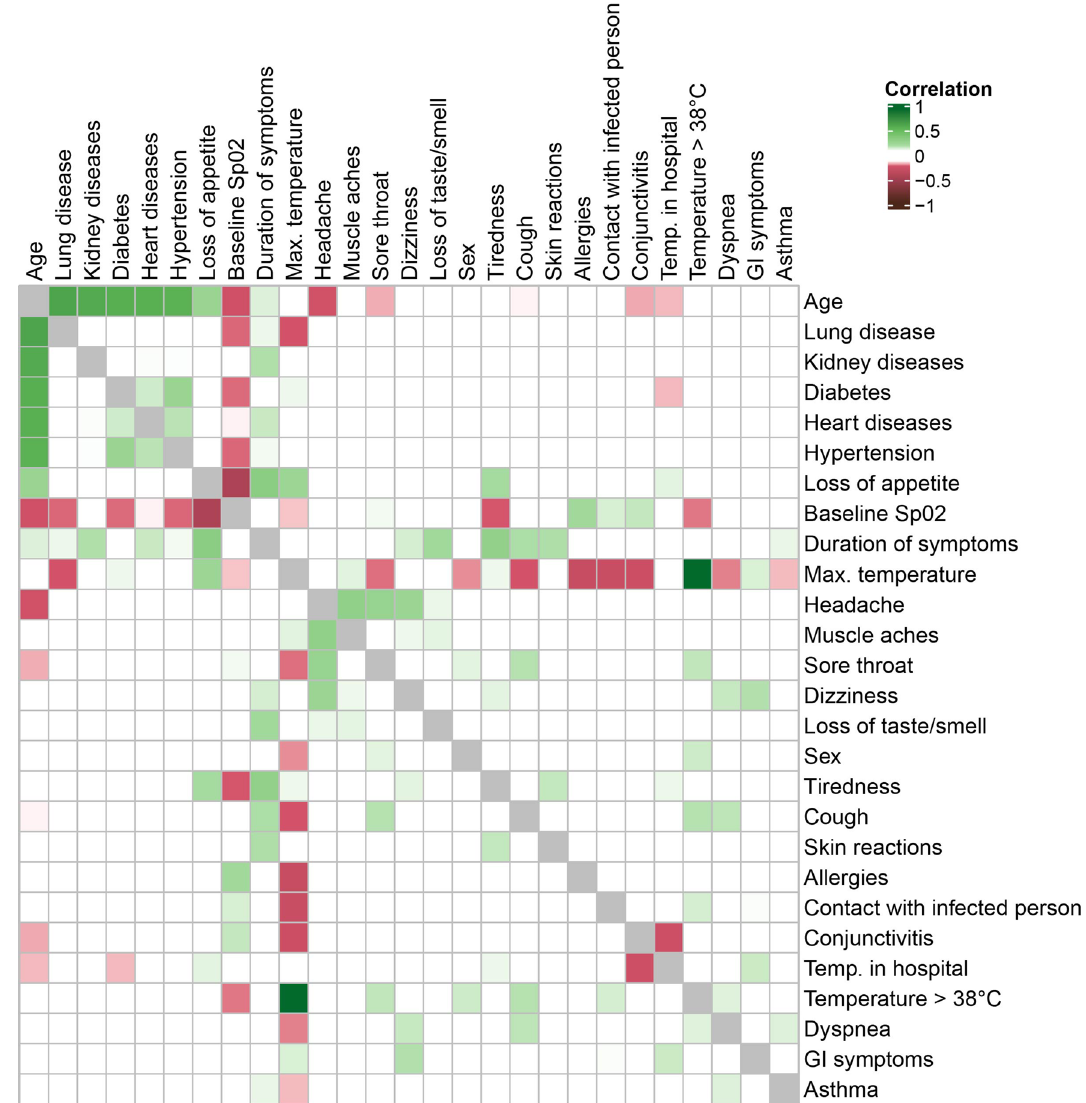
Figure 2. Heatmap with correlation coefficients for pairwise comparison of queries. Blood type was ignored due to different interpretation of the effect size coefficient. Comparisons with at least a small effect size have been coloured, i.e. values of correlation within the range (− 0.1, 0.1) were left picture of the associations with COVID-19 disease (see Supplementary Figure S2). Muscle aches, headache, sore throat and dizziness have been inspected for co-appearance with symptoms mentioned above. Occurrence of muscle aches or headache only gives nonsignificant OR for COVID-19 diagnosis, while com- bination with some of the main symptoms changes OR significantly. For example, the co-occurrence of headache with cough and loss of taste/smell increases the estimate of odds ratio from OR = 2.49 to OR = 3.74, while co- occurrence of muscle ache with the two main symptoms does not impact their OR (2.49 versus 2.15). However, the co-occurrence of the four mentioned above symptoms (cough, loss of smell/taste, headache and muscle ache) results in higher OR = 4.72. The prediction power of the symptom‑based classifiers. Additionally, to support the early-stage symptom-based decision on the patient being or not SARS-CoV-2 positive, the LR-based predictors were also built for a different subset of the nine main symptoms considered (N = 398). The summary of the results is presented in Supplementary Table S2 which provides the expanded list of the classification quality indices and their 95% CI obtained in tenfold cross-validation. Among the single-symptom models, the loss of taste/smell- based classification gives the best AUC = 0.634 (95% CI 0.603–0.665) and DOR = 3.670 (95% CI 2.494–4.847). The highest AUC (> 70%) and DOR (> 3) values were obtained for the three symptom signatures: (1) tempera- ture > 38°C & cough & loss of taste/smell & GI symptoms (AUC 0.704, 95% CI: 0.632–0.776 and DOR 8.991, 95% CI: 3.792–14.191); (2) dyspnea & cough & loss of taste/smell & GI symptoms (AUC 0.705, 95% CI: 0.640–0.769,